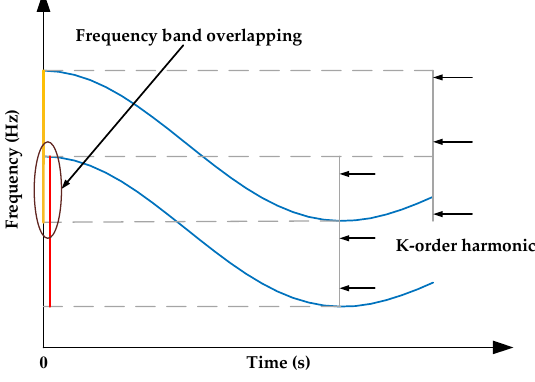
Figure 1. Frequency band overlap.